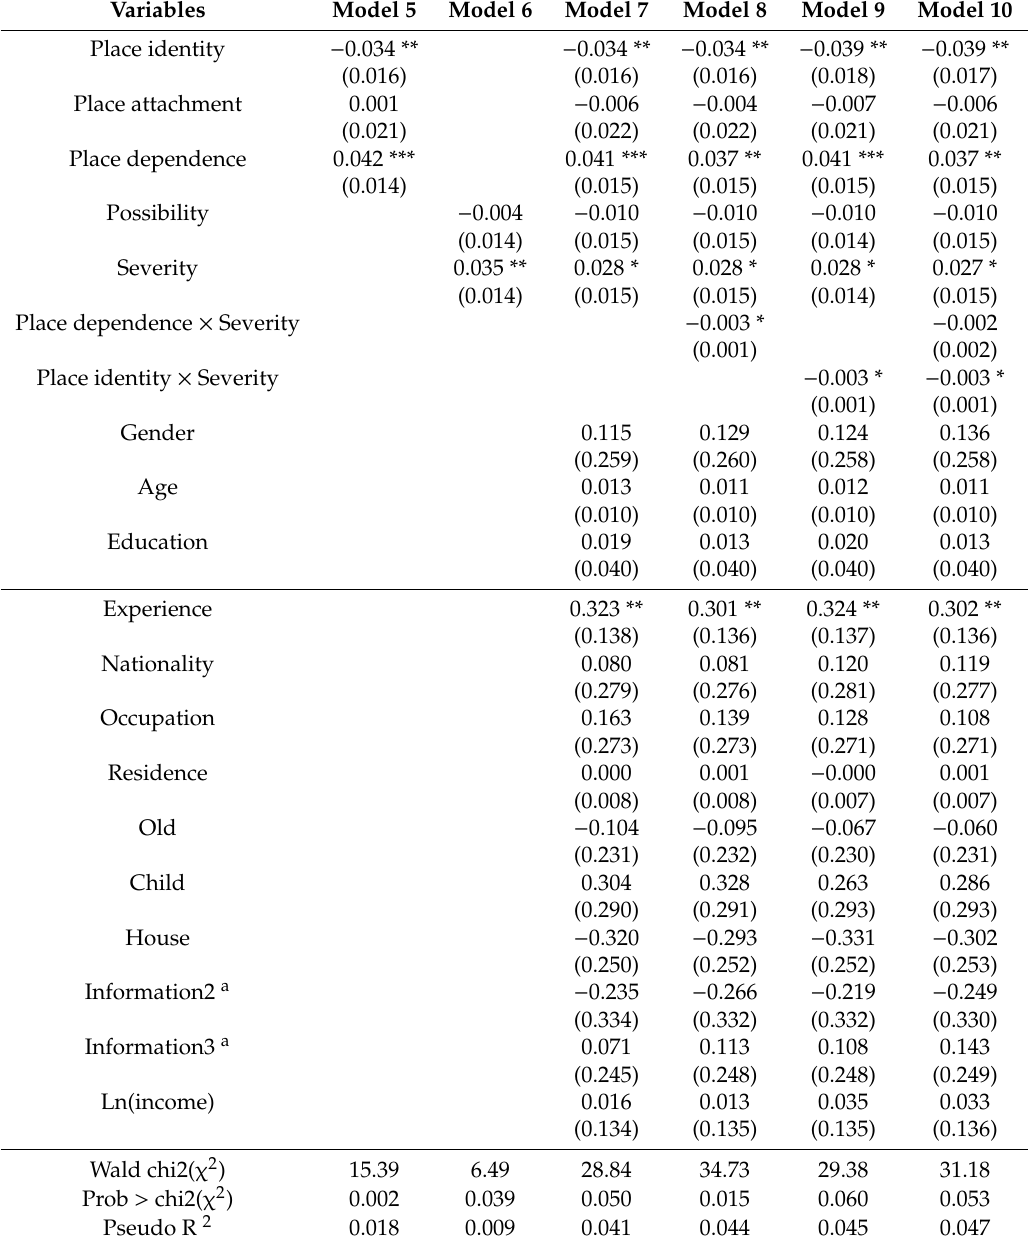
Table 7. Regression results of residents’ disaster risk perception, sense of place and relocation